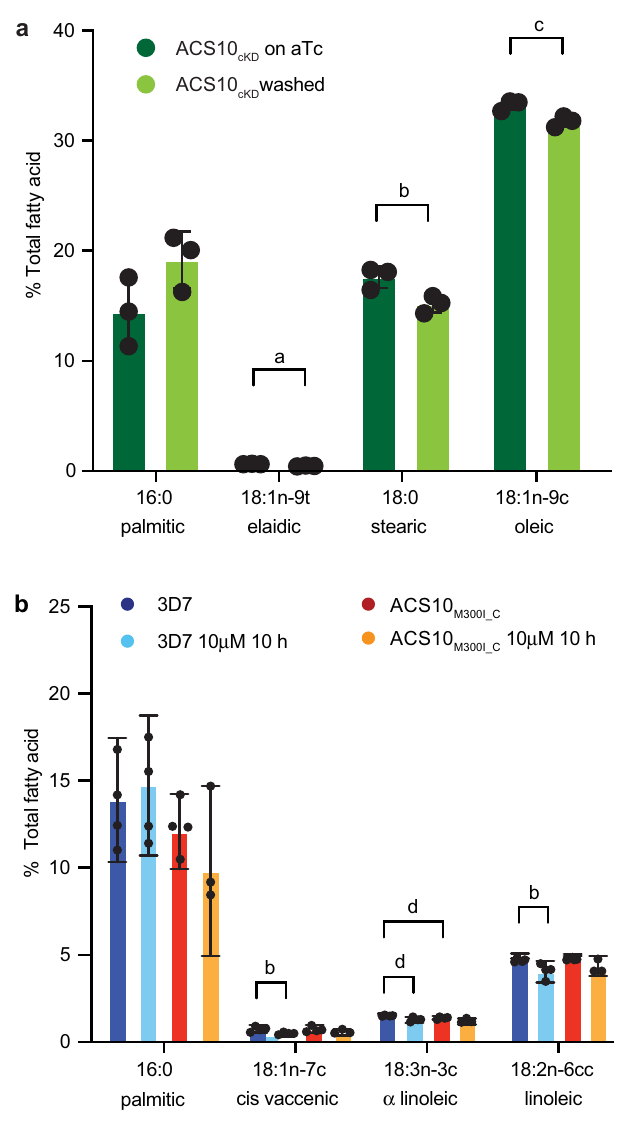
Fig. 7 | Pf ACS10 prefers fatty acid species of 18 carbon length. a ACS10 cKD parasites were washed 24h prior to enrichment for trophozoites by MACS pur- i fi cation to allow for reduced levels of Pf ACS10. Under these aTc washout condi- tions, there was no visible defect in the ACS10 cKd line. FAs form infected erythrocytes were extracted and submitted to gas chromatography- fl ame ioniza- tion detection (GC-FID); results were normalized to total FA. Shown are the mean±SD of three biological replicates for relevant fatty acids. b 3D7 and ACS10 M300I_C were enriched for young trophozoites and exposed to 10mM MMV665924orDMSOfor10h,afterwhichFAswereextractedandanalyzedbyGC- FID. Shown are the means±SD of four biological replicates for relevant FAs. Test forsigni fi canceusedtwo-sidedunpairedStudent ’ s t test,a: p =0.006,b: p =0.03,c: p =0.02, d: p =0.01. The complete data for the GC-FID are available in Supple- mentary Data 7 and 8. aTc anhydrotetracycline, FA fatty